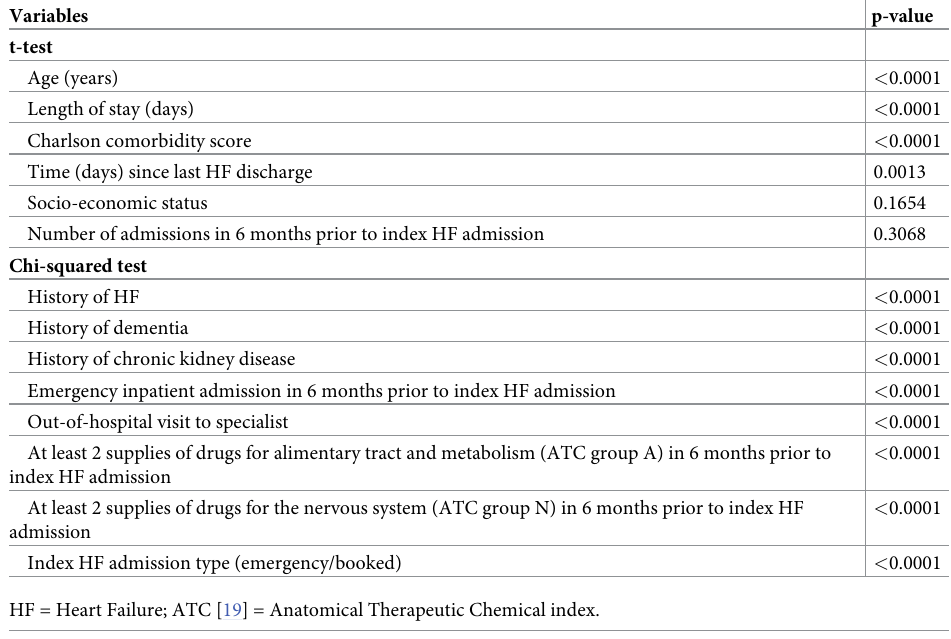
Table 2. Variables selected by the statistical method (t-test and chi-squared test) for predicting 30-day HF read- mission or death (sorted in ascending order of